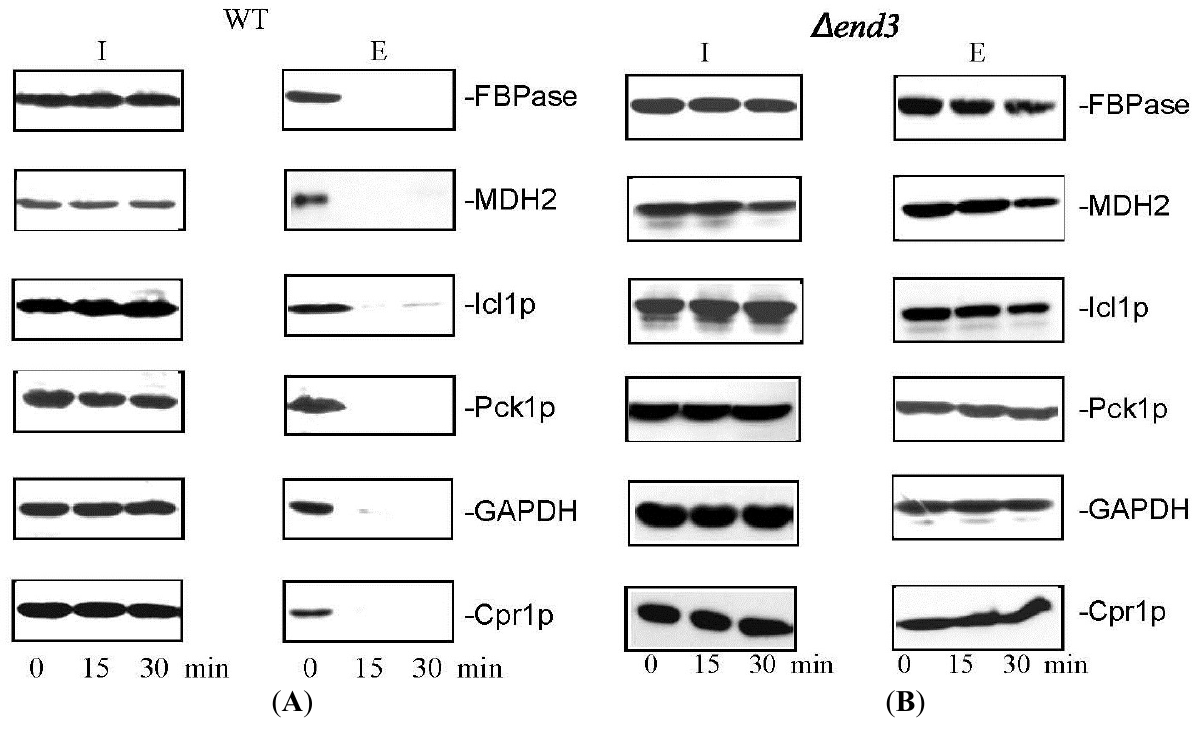
Figure 4. The decline of extracellular FBPase, MDH2, Icl1p, Pck1p, GAPDH, and Cpr1p in response to glucose re-feeding is dependent on END3 . Wild-type cells ( A ) and the ∆end3 cells ( B ) were starved of glucose for 3 days and re-fed with glucose for 0, 15, and 30 min. Western blotting was used to examine levels of FBPase, MDH2, Icl1p, Pck1p, GAPDH, and Cpr1p in the intracellular (I) and extracellular (E) fractions. This figure is